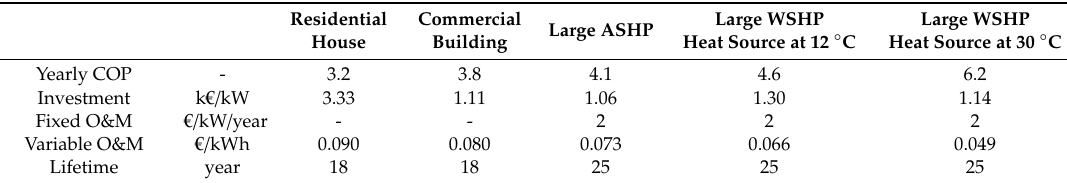
Table 1. Capital and operating costs for heat